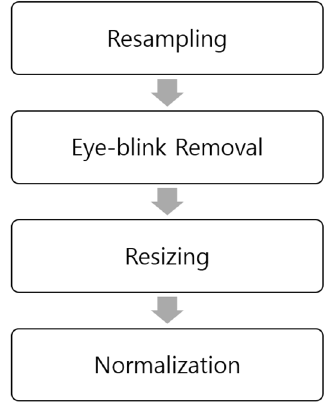
Figure 3. Preprocessing flow.